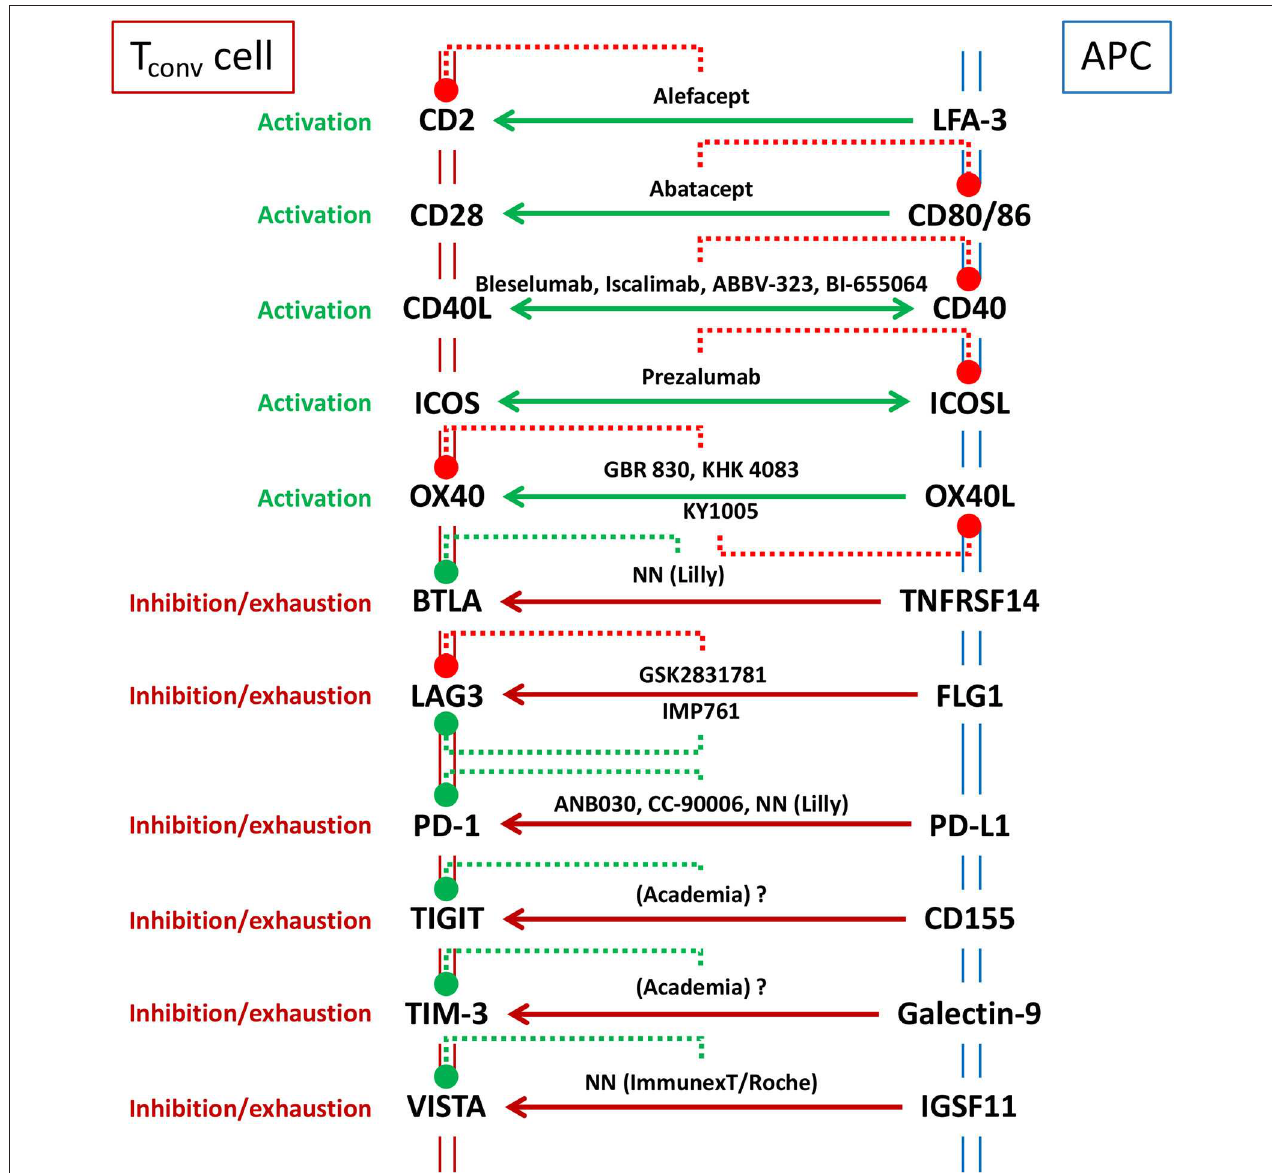
FIGURE 2 | Major immune checkpoints considered as targets for immunotherapy to ameliorate AID. Solid lines represent intended targeted intervention (e.g., only targeting T cell function -unidirectional arrow to T cell side-, or also blocking helper/effector T cell function -bidirectional arrow- as in CD40/CD40L therapies that aim for the inhibition of T cell activation as well as the prevention of germinal center formation). The best known immunotherapeutics, registered or under development (see text), are included in the scheme indicating (with dotted lines) their receptor specificity and whether they are antagonist (red) or agonistic (green). GSK2831781 is displayed as a “functional” antagonist since the main function of the mAb is to eliminate LAG3 expressing cells, rather than agonizing this coinhibitory pathway, as it is the case for IMP761. NN means compound code not named (not known in public domain).